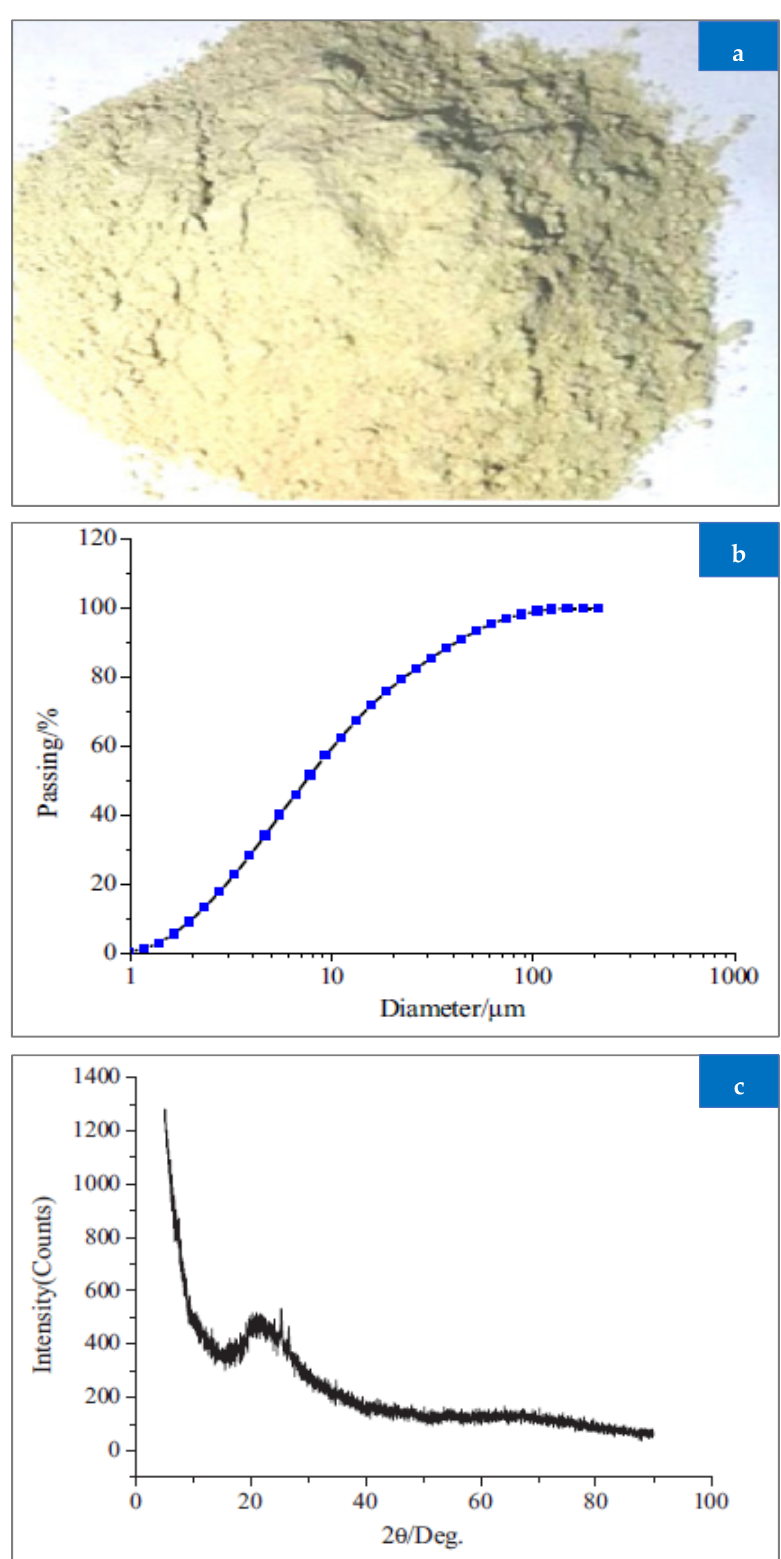
Figure 3. ( a ) MTK [43] ( b ) Gradation Curve of MTK and ( c ) XRD of MTK: Reprinted with permission from [44] .